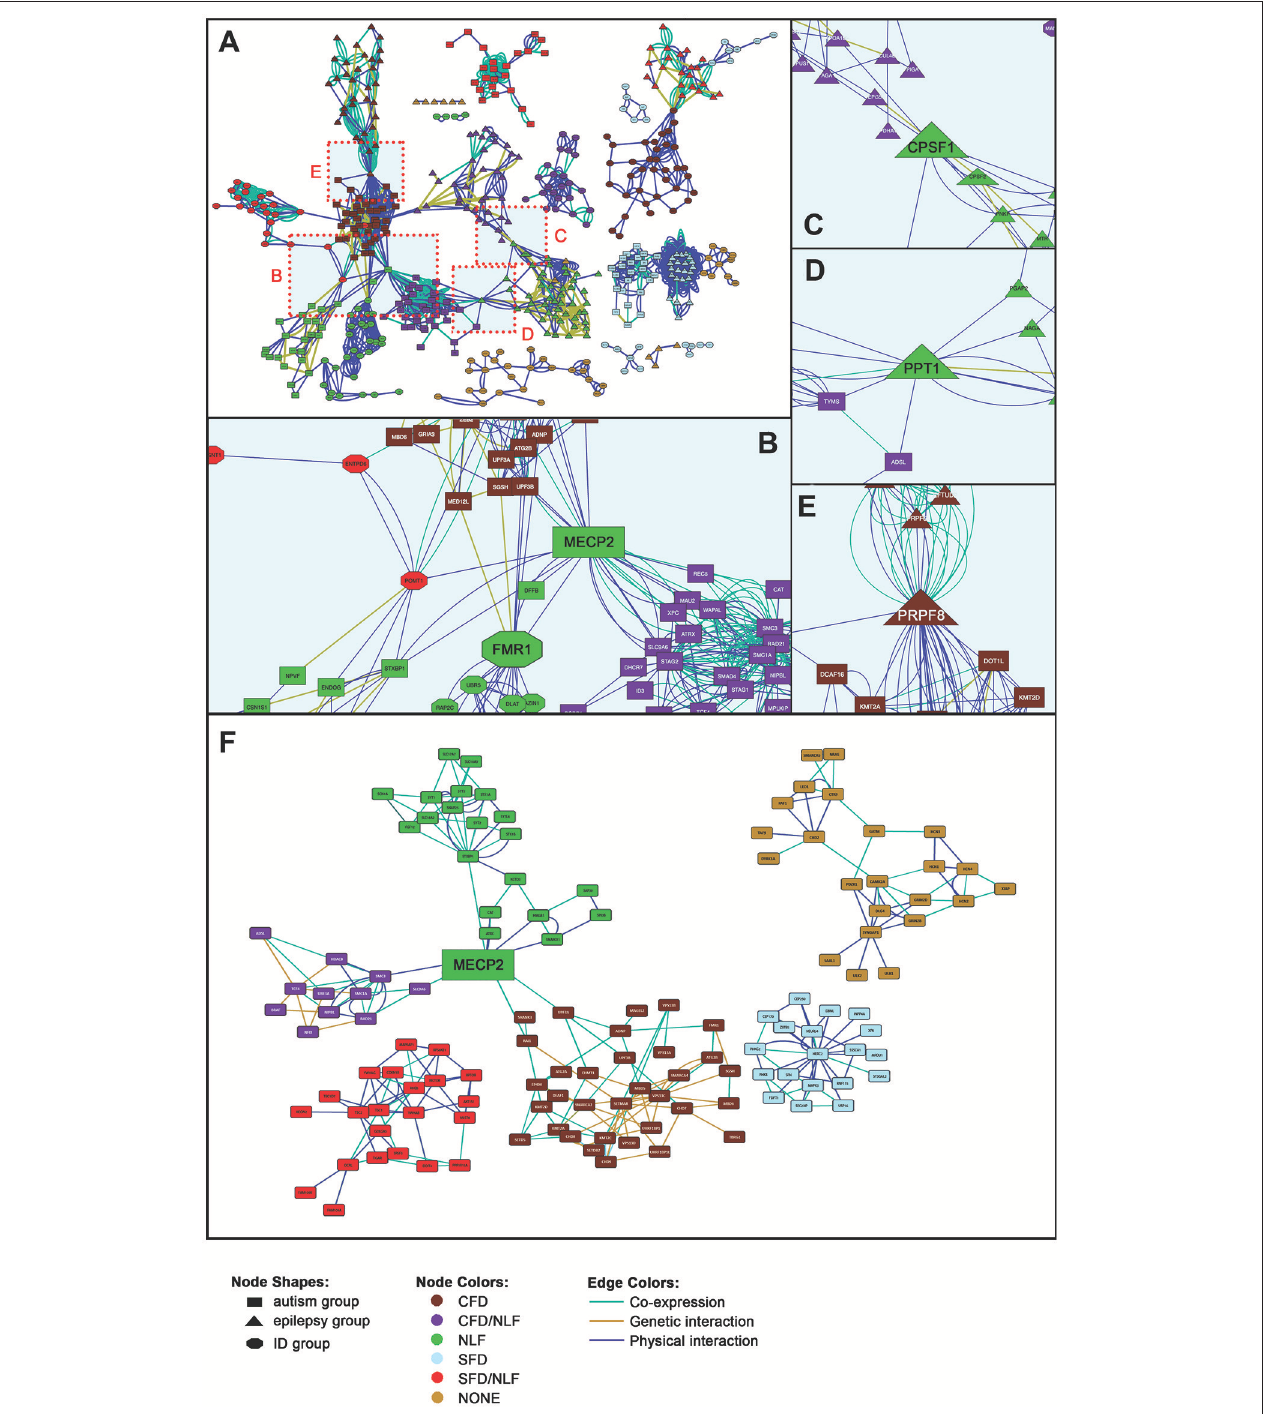
FIGURE 2 | Gene Interaction Network. (A) Full gene interaction network. (See Supplementary Figure 1 for detailed gene network). (B) Autism-linked MECP2 and FMR1 hubs. (C) Epilepsy-linked CPSF1 hub. (D) Epilepsy- and autism-linked PPT1 hub. (E) Epilepsy- and autism-linked PRPF8 hub. (F) Syndromic SFARI gene interaction network. (See Supplementary Figure 2 , for detailed gene